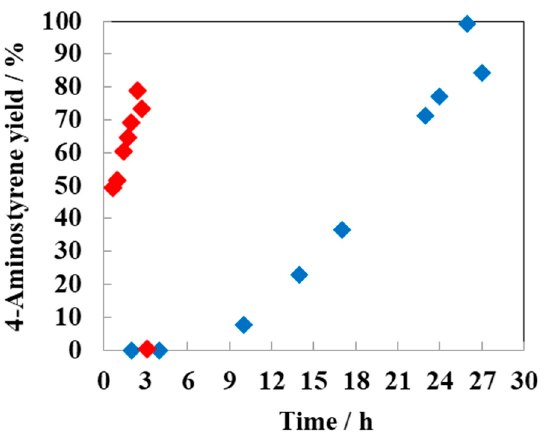
Figure 4. Time profile for the chemoselective hydrogenation of 4-NS to 4-AS by TiO 2 -sup- ported (red diamond) and unsupported (blue diamond) Ni 3 Sn 2